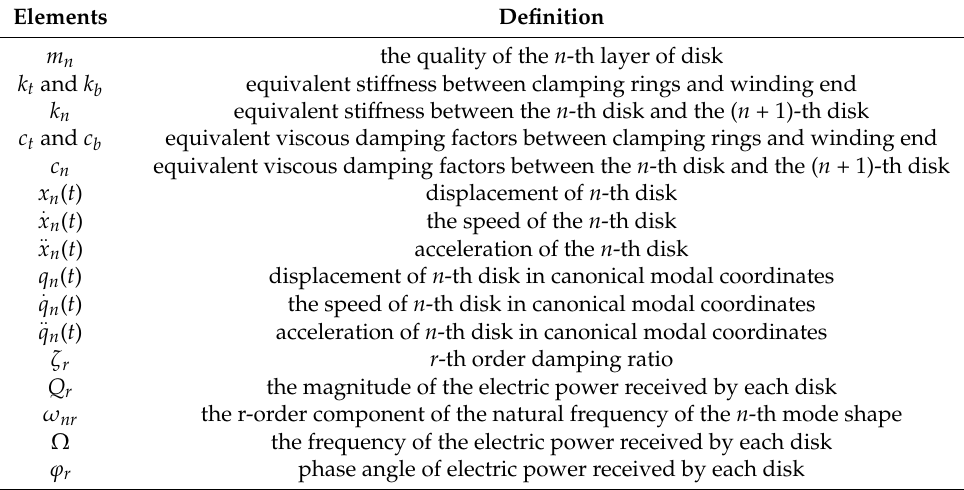
Table 1. Definition of elements in the multi-DOF